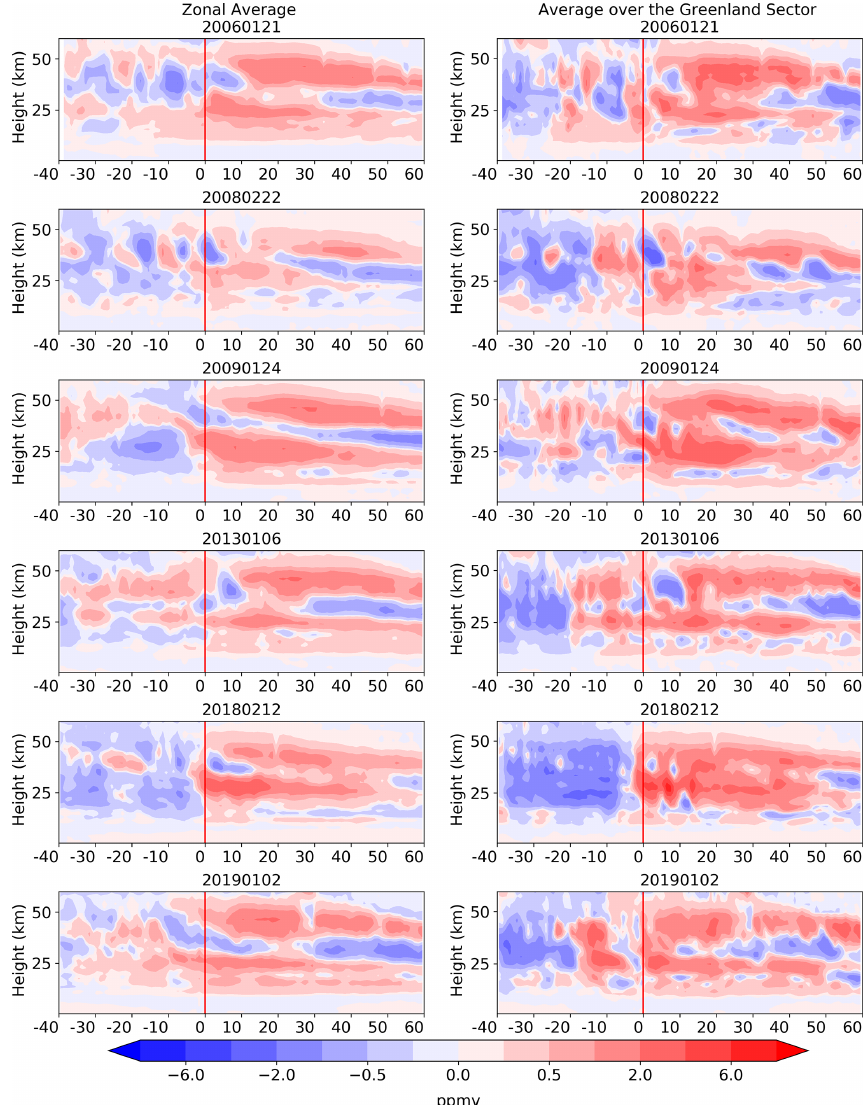
Figure 8. The cross-section of ozone anomaly during the 40d before to 60d of each SSW averaged over the latitude band 60–80 ◦ N and Greenland sector (60–80 ◦ N, 10–70 ◦ W). The vertical red line shows the SSWs’ incident date. Climatology was created using non-SSW years since 2004. The vertical coordinate is the log-pressure